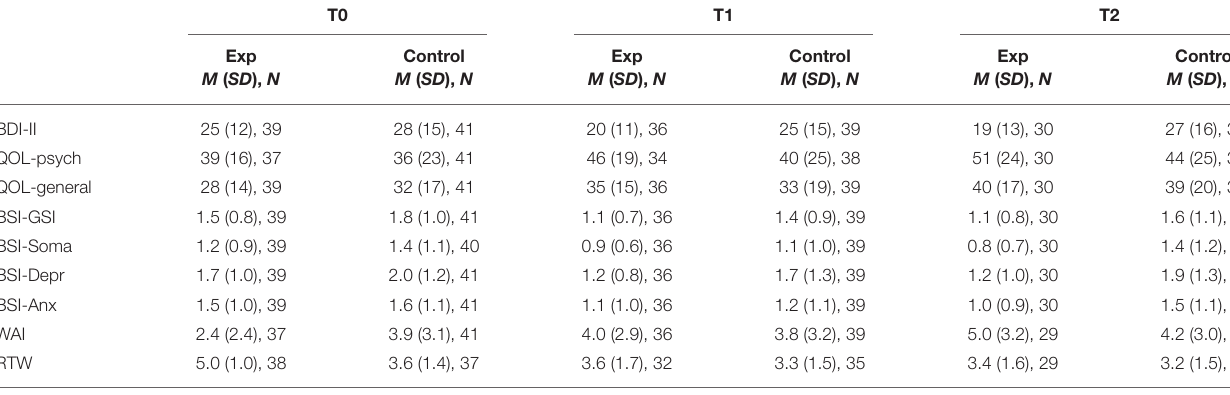
TABLE 4 | Descriptive statistics, separately for assessment time (T0, T1, and T2) and group (intervention vs. control).